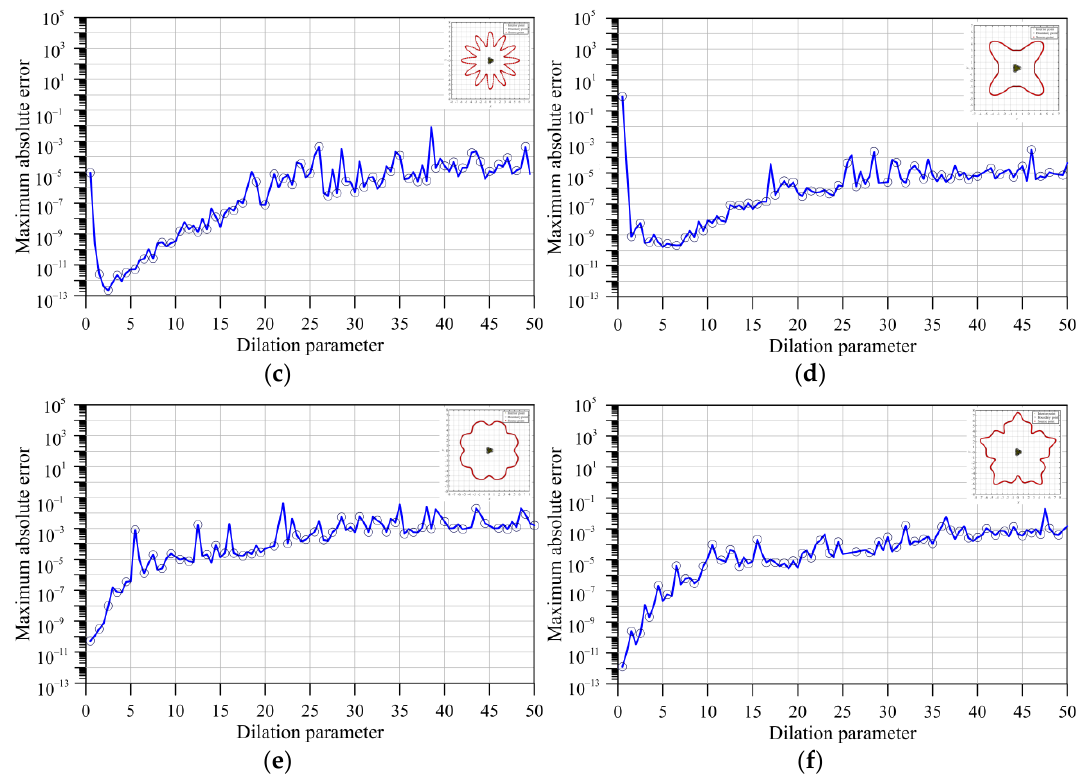
Figure 4. The computed MAE versus the dilation parameter ( k = 1 ) ( a ) Case I; ( b ) Case II; ( c ) Case III; ( d ) Case IV; ( e ) Case V; ( f ) Case VI.